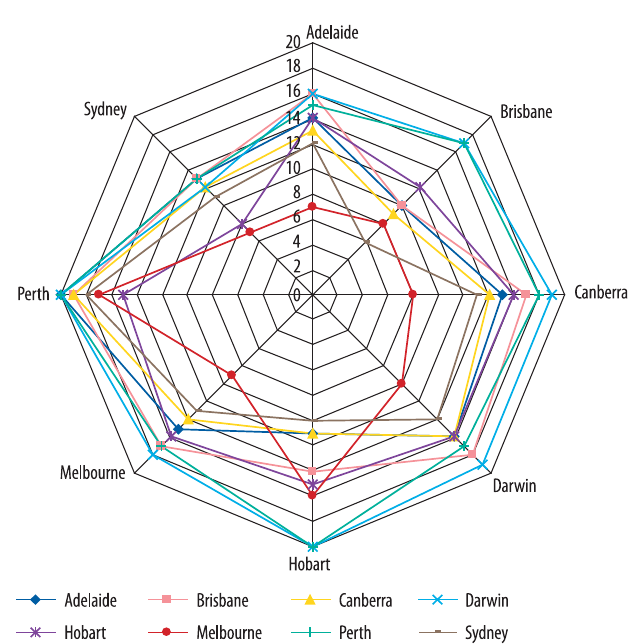
Figure 4. Lagged terms when fi rst reaching a value of impulse response of less than